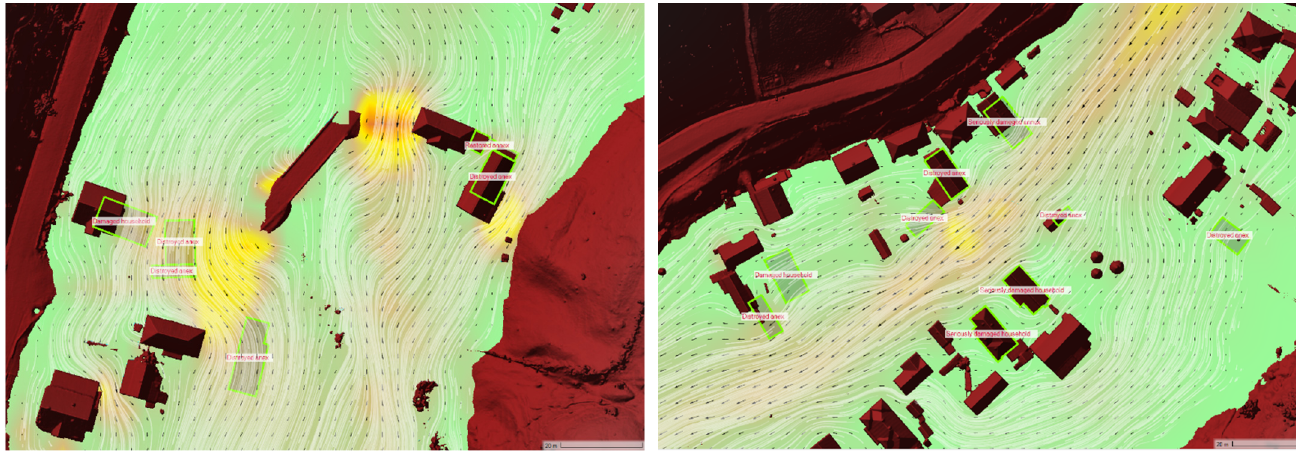
Figure 8. The cumulated effects of shear stress and velocity on the road infrastructure and build- ings.